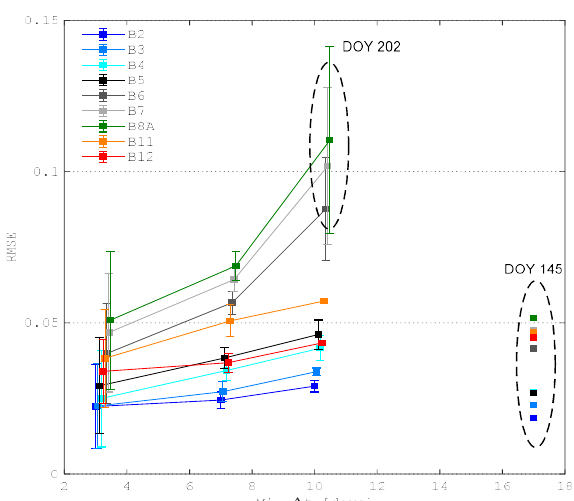
Figure 3. RMSE between surface reflectance datasets from S2-LIKE and S2-MSI as function of the temporal interval to clear-sky S2-MSI image used for training ( 𝑀𝑖𝑛_∆𝑇 ): points (error bars) present the mean (standard deviation) of RMSE values obtained for spectral band predictions with equal 𝑀𝑖𝑛_∆𝑇 .